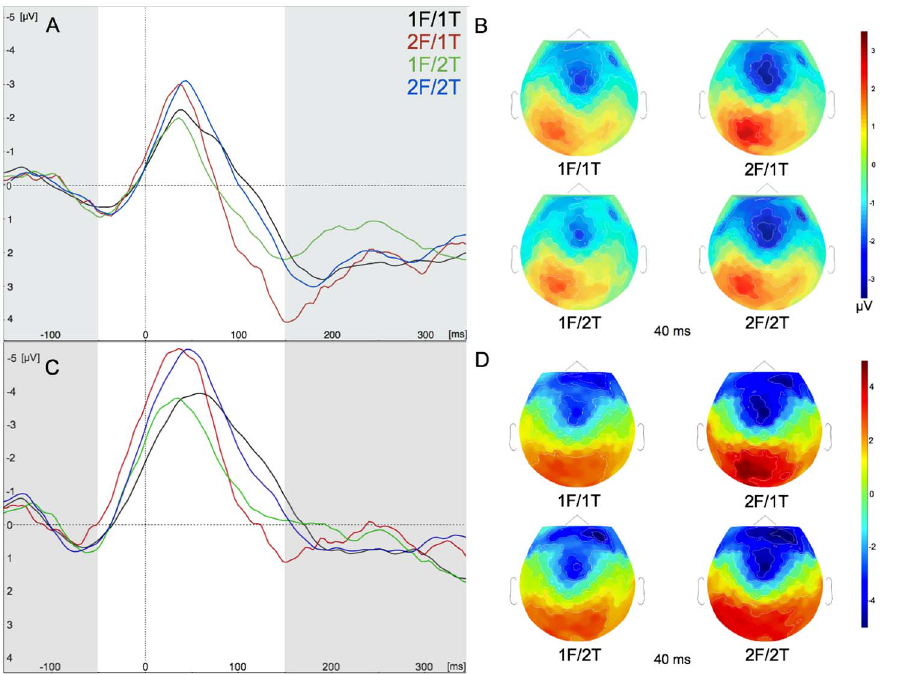
Figure 4. The amplitude of the error-related negativity (ERN) was increased when two fingers were represented in the flanker, whereas the representation of the response in the target had no effect on the amplitude of the ERN. Response alternatives were defined by the number of fingers represented in the target and flanker: one-finger flanker (1F) and one-finger target (1T), or two-finger flanker (2F) and two- finger target (2T). ( A ) Grand-average raw error waveforms from 2 150 to 350 ms locked to the response at the FCz ROI in the incongruent direction condition. ( B ) Scalp topographies of the grand-average raw waveforms in each condition at 40 ms after the response. ( C ) Grand-average error-correct difference waveforms locked to the response at the FCz ROI in the incongruent direction condition. ( D ) Scalp topographies of the grand-average difference waveforms in each condition at 40 ms after the response. Highlighted timeframe on grand-averaged waveforms represents the window used for detecting the peak amplitude of the